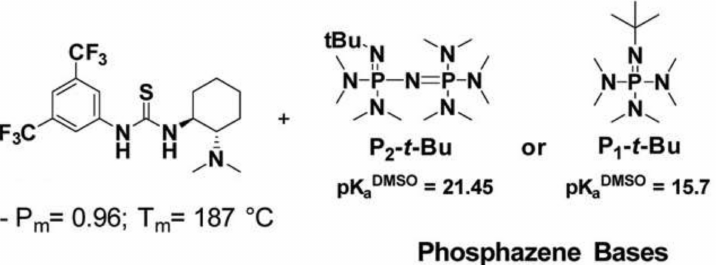
Figure 3. Organocatalysts for stereoselective ROP of rac-LA, adapted from reference [115]. Copyright @ 1996 RSC, License Number: